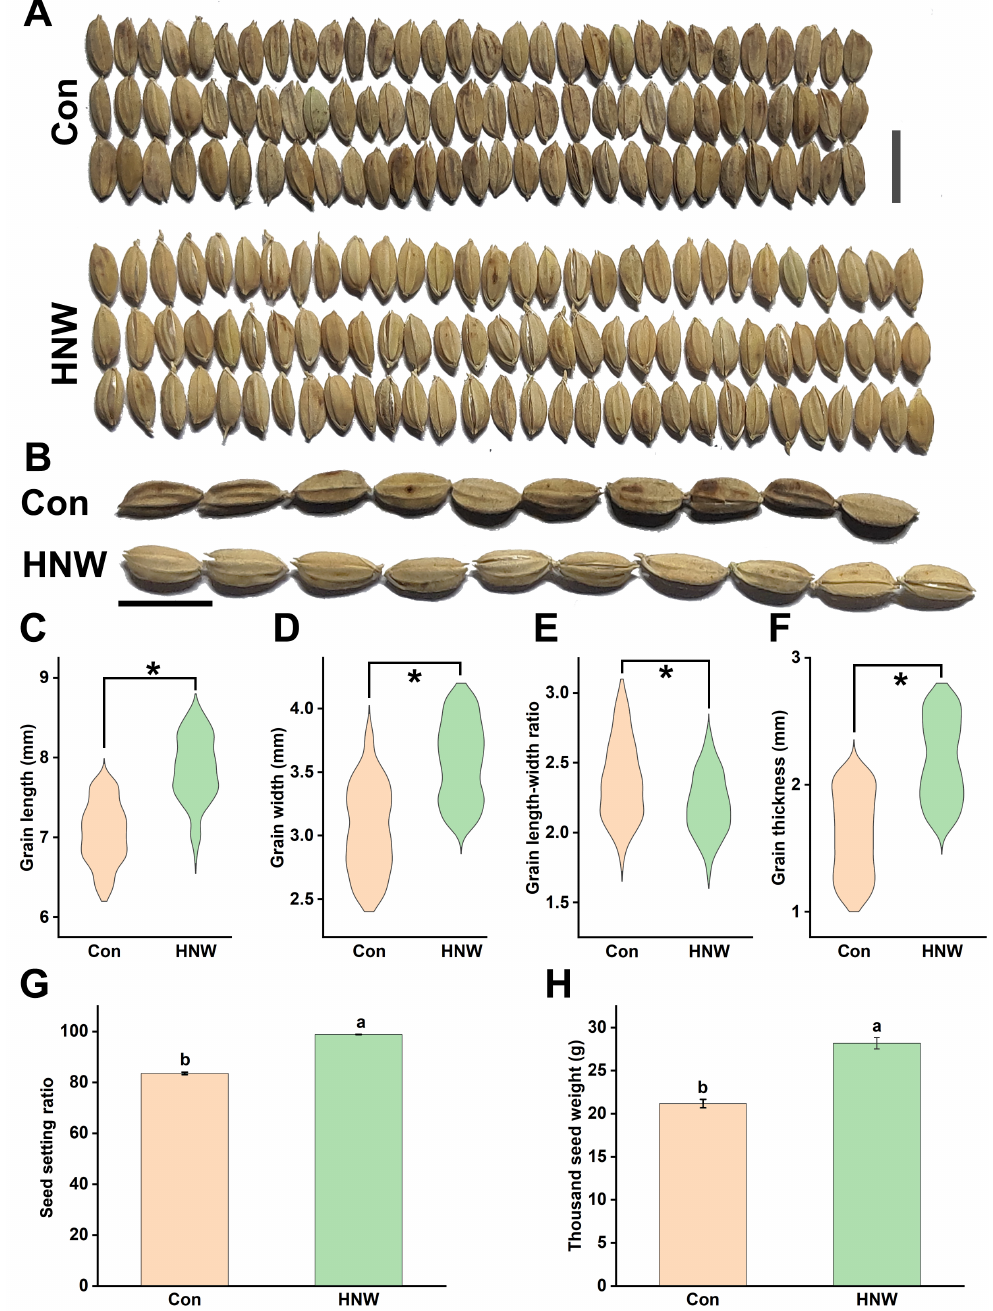
Figure 1. HNW positively influences the size and weight of grains. The photographs of representative 30 grains ( A ) and 10 grains ( B ) were taken (bar = 1 cm). Parameters of rice size, including grain length ( C ), width ( D ), length-width ratio ( E ), thickness ( F ), seed setting ratio ( G ), and thousand seed weight ( H ), were also provided. Asterisk indicates a significant difference between Con and HNW (n ≥ 1000, p < 0.001, two-way Student’s t-test). Data are mean ± SD (n = 3). Bars with different letters were significantly different in comparison with Con at p < 0.05.